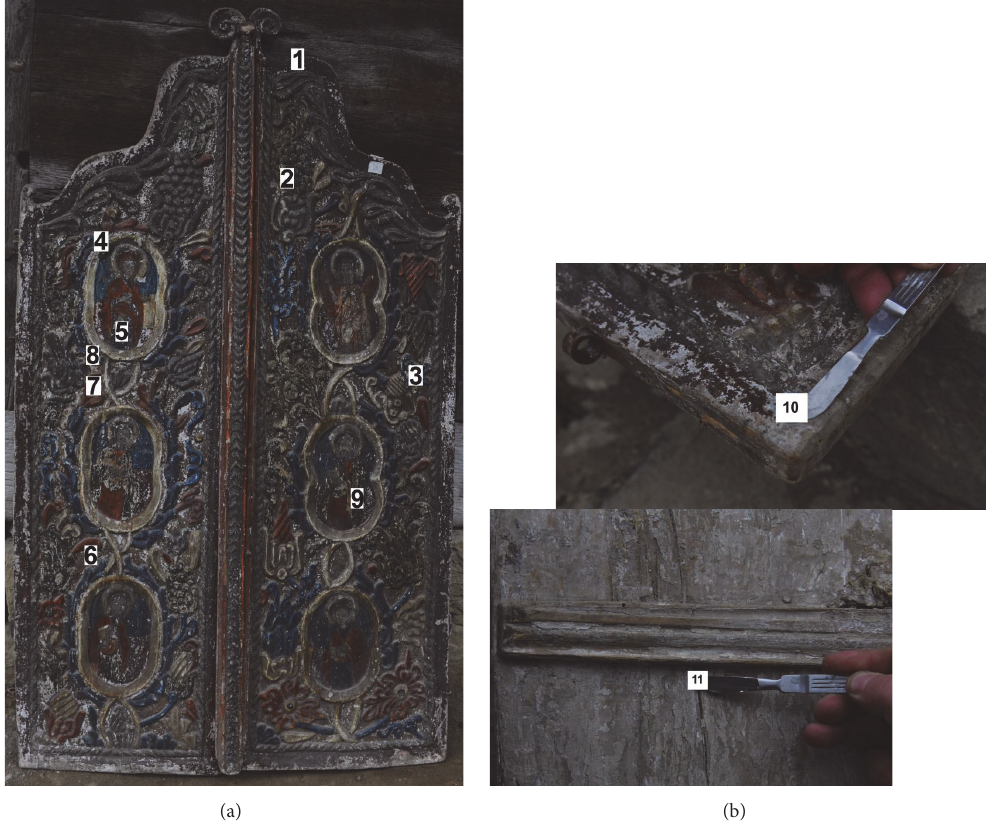
Figure 1: (a) Imperial Gates of the wooden church and some sampling points. (b) Imperial Gates of the wooden church (rear side) and two sampling